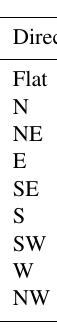
Table 1. Categorization of slope aspect into classes of 45 ◦